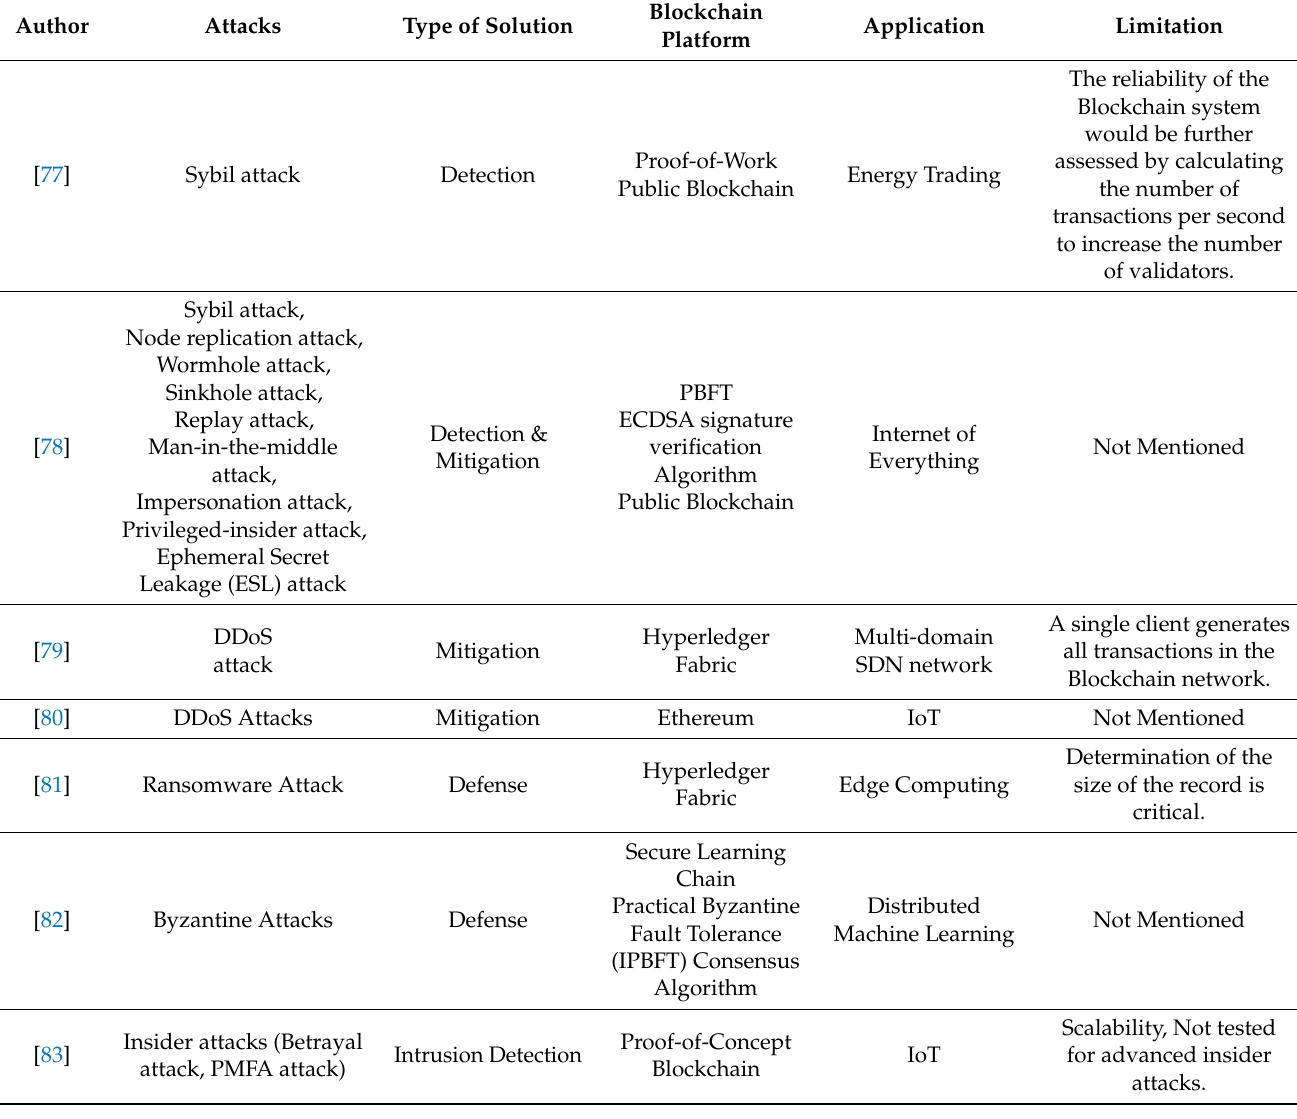
Table 20. Blockchain as a solution to detect and mitigate different